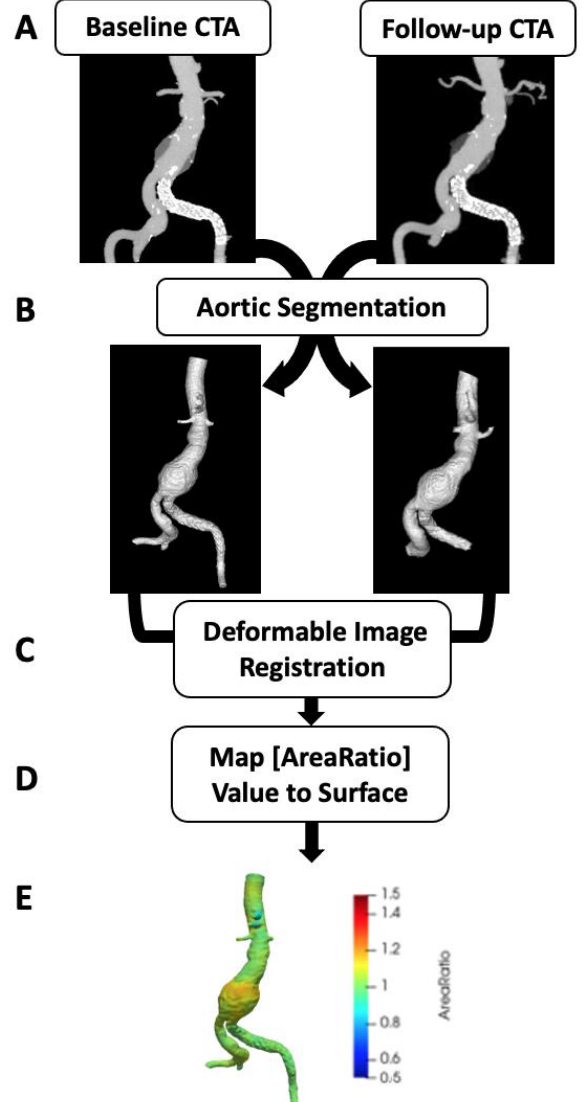
Figure 1. Vascular deformation mapping (VDM) workflow. Computed tomography angiography (CTA) images at two separate points in time are the source data for VDM ( A ) and undergo seg- mentation of to generate a mask of the AAA used to delimit the registration ( B ). Then multi-step registration is performed, first using rigid registration to align the 2 CTs followed by deformable registration to generate a deformation field, which is used to transform the baseline aortic mesh ( C ). The ratio of the surface area change (Area Ratio) at each triangular mesh element between baseline and follow-up CTAs is calculated ( D ) and the Area Ratio values are subsequently visualized by plotting values on the aortic surface using a colorized scale ( E ).